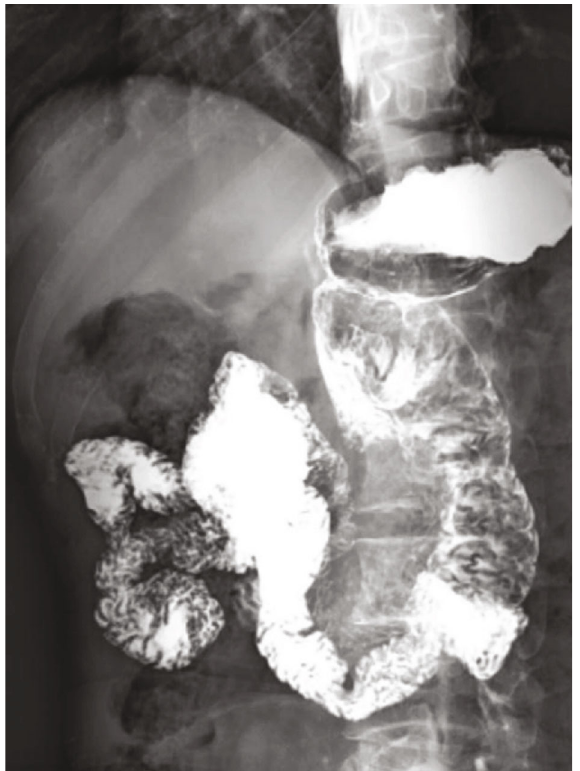
Figure 2: The gastrointestinal barium test showed that the barium agent passed the anastomotic site smoothly, and there was no retuning at the ligation site of line